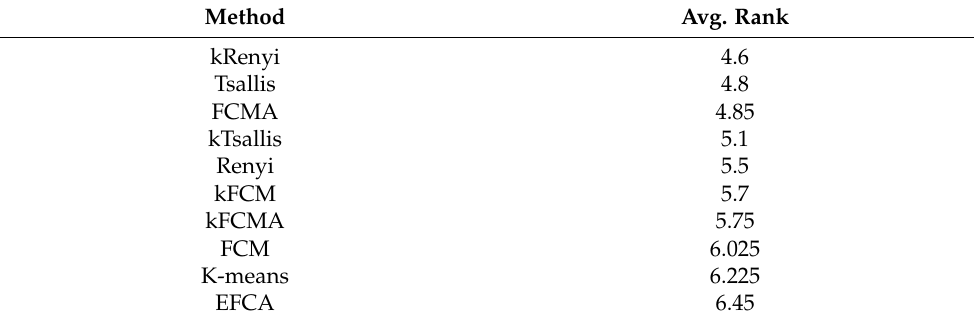
Table 5. Average ranks of the compared methods in the Friedman rank